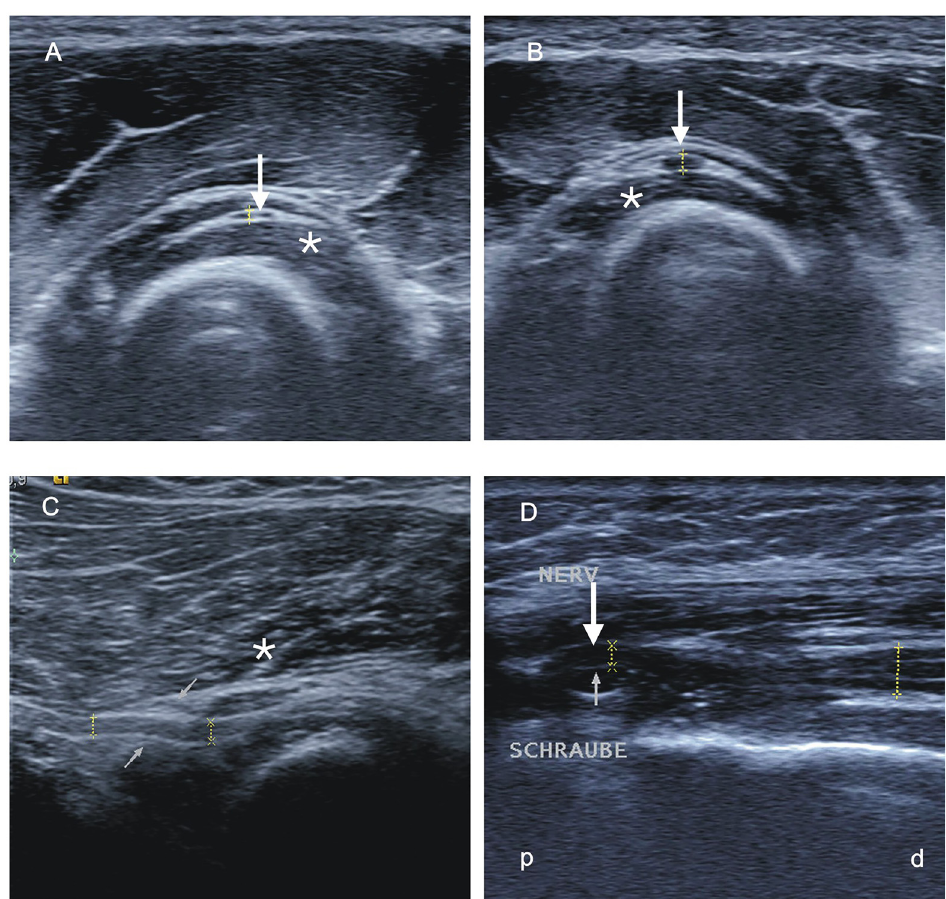
Fig 1. Sonographic studies of a patient with a proximal radial nerve lesion. (A, B) Transversal study of the posterior interosseous nerve (PIN; arrow) within the supinator muscle (asterisk) on the healthy side (A) in comparison to the affected side (B) with a significant swelling of the PIN within the muscle. (C) Longitudinal study of the PIN with a swelling before entering the Arcade of Frohse (thin arrows) and within the supinator muscle (asterisk). (D) Longitudinal study of the radial nerve in the distal upper arm with impression of the nerve (arrow) by a screw (thin arrow). p — proximal, d —